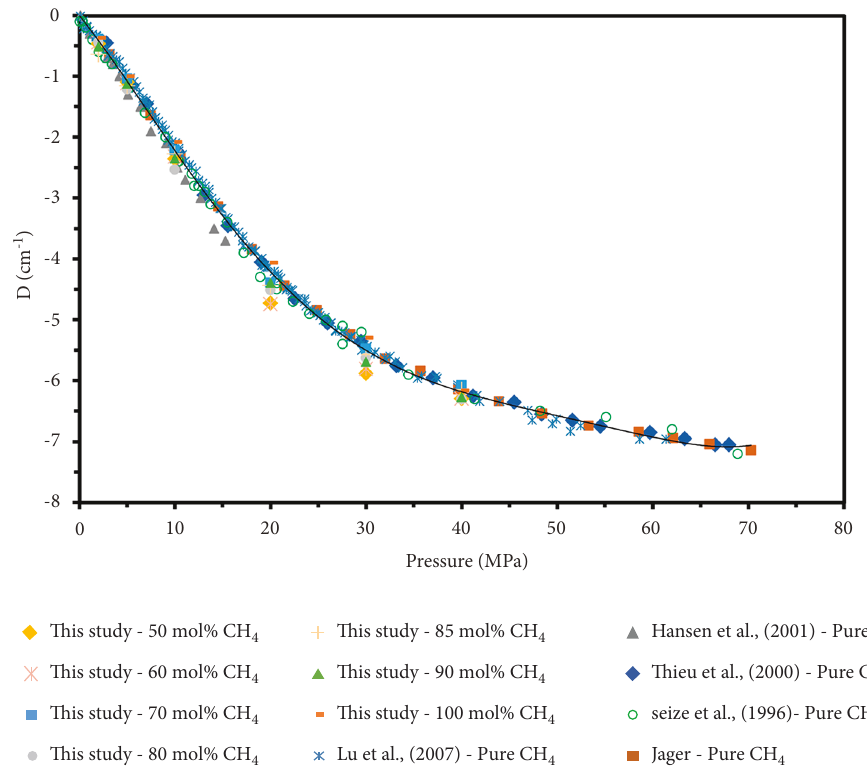
Figure 5: The P-D relationship determined in this study compared with other published values at near room temperature. Note that the original data of Jager’s Colorado School of Mines are cited from Lu et al.